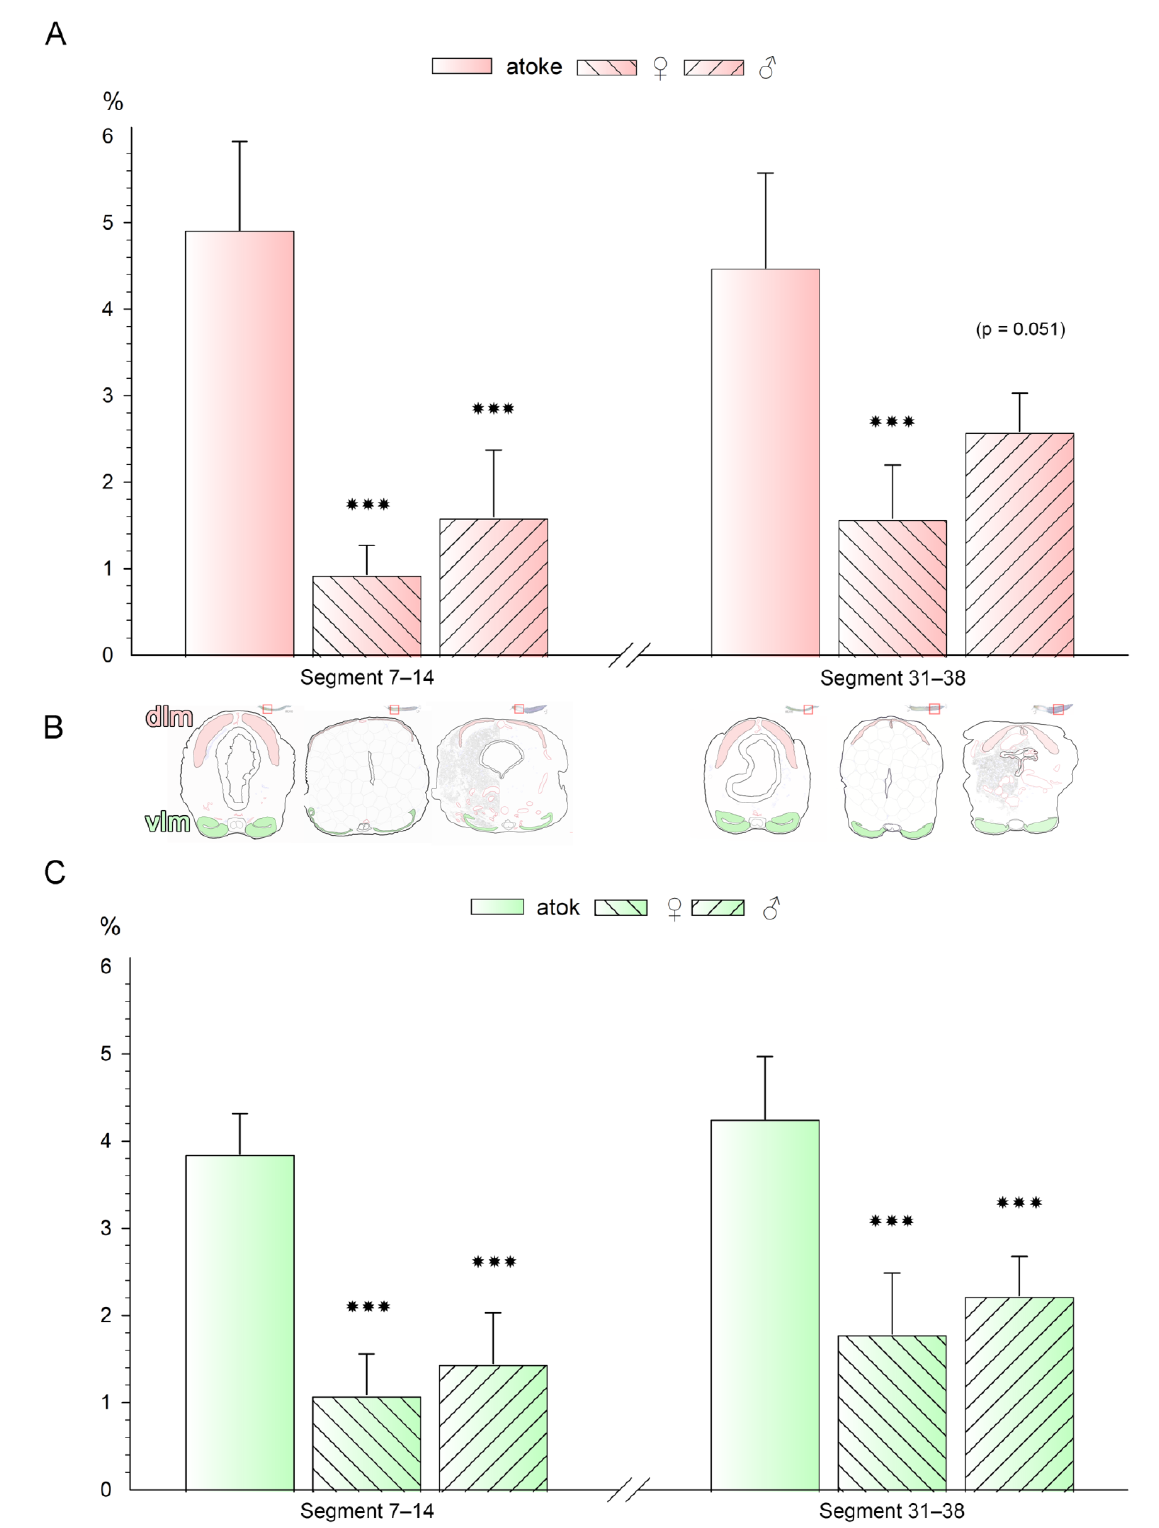
Figure 2. Dorsal and ventral longitudinal muscles are significantly reduced in anterior and posterior segments after maturation. ( A , C ) The quantification of the comparative measurements of the total longitudinal muscle size in the ( A ) dorsal or ( C ) ventral longitudinal muscles of atokous, female ( and male ( ) individuals. Data were obtained from four replicate measurements of each ♂